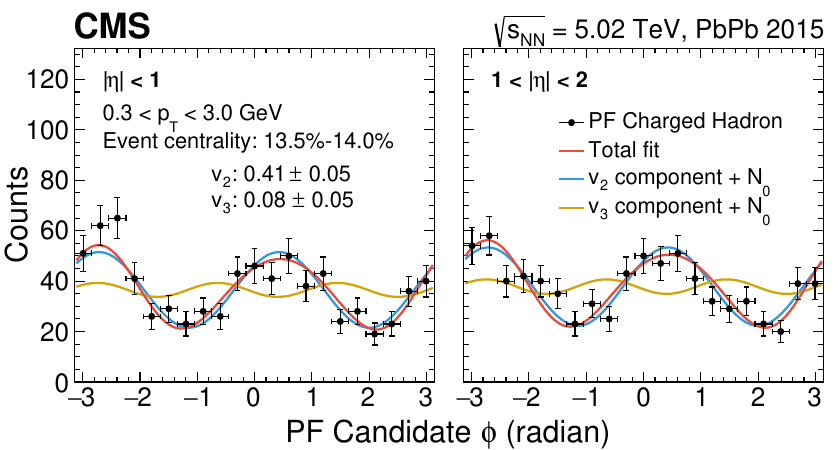
Figure 1 . (Color online) Azimuthal angle distributions for a single PbPb event: φ modulations at mid-rapidity | η | < 1 (left) and forward rapidity 1 < | η | < 2 (right) of charged-hadron PF candidates. The v (blue curve) and v (yellow curve) of the flow components are shown, together with the total 2 3 modulation used in the analysis to account for the background (red curve). The flow coefficients are extracted from the left plot and overlaid in the right